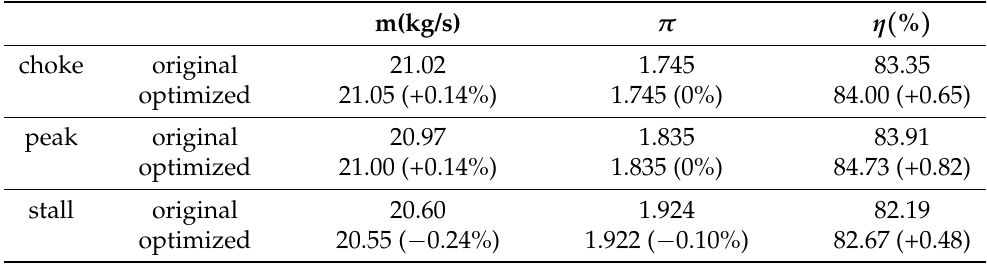
Figure 16. Evolution histories of the weighted objective functions and constraints for the NASA Stage 35. Table 3. Comparison of aerodynamic performances between the original and optimized blade profiles for the NASA Stage